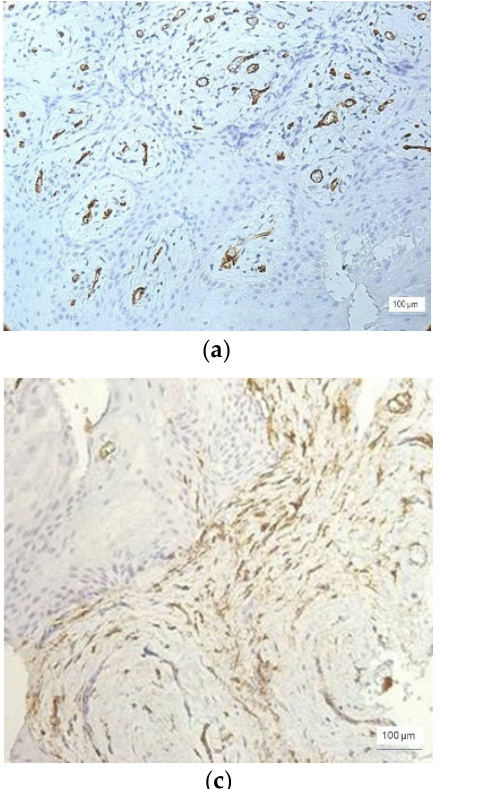
Figure 8. ( a – c ) Capillaries in the basal layer of the epithelium, anti-CD34 immunohistochemical staining, and DAB chromogen, ×200 magnification.